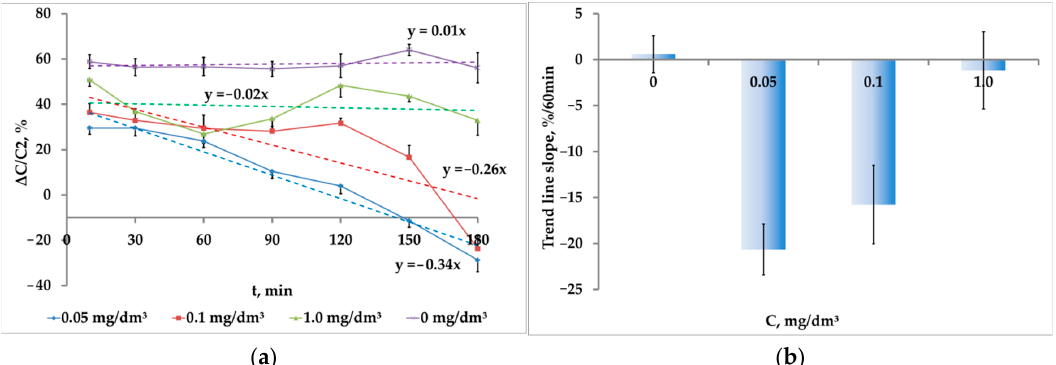
Figure 11. Approximation of the dynamics of the Δ C/C 2 ratio ( a ) and the slope of fitting lines ( b ) under the influence of various concentrations of microplastics on A. salina .